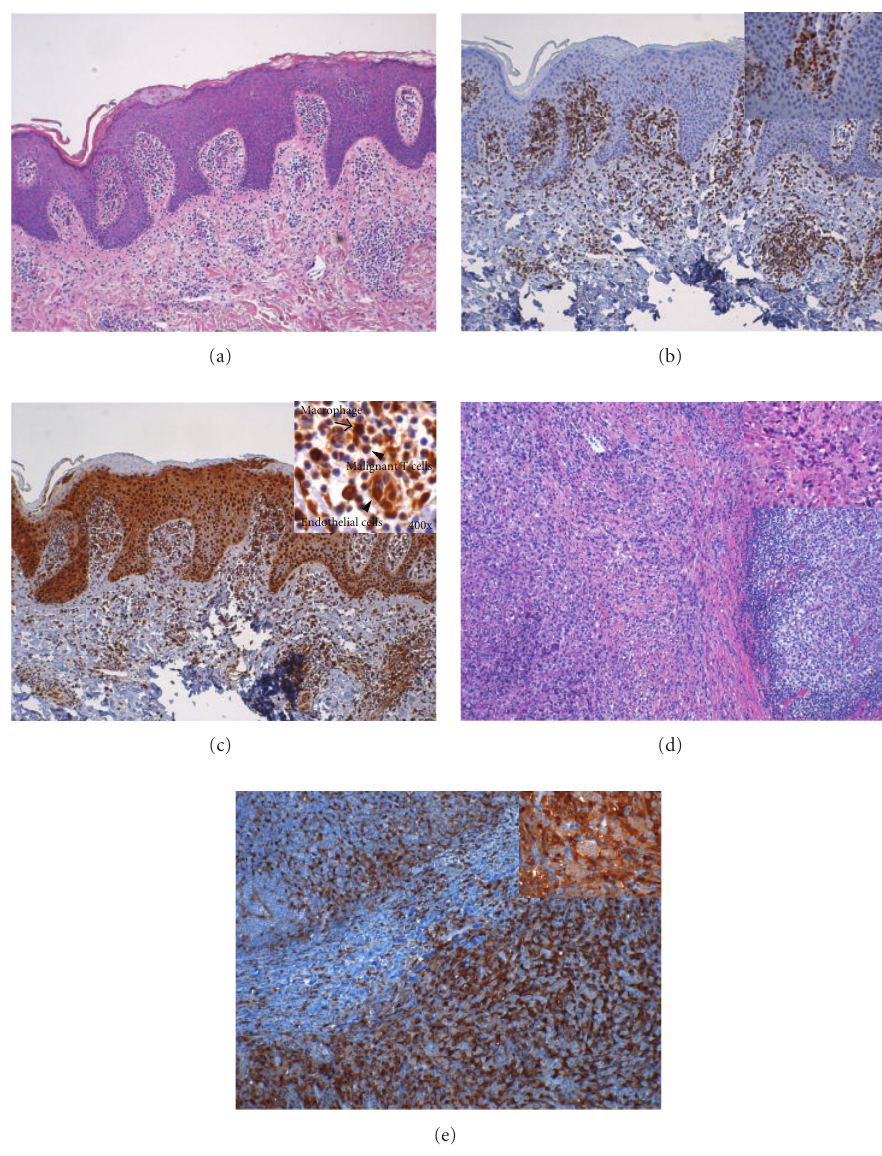
Figure 2: Immunohistochemical stain of thymidine phosphorylase (TP) expression and related markers in skin-involved mycosis fungoides (MF-skin) and in a case of mycosis fungoides/S´ezary syndrome cells with involved lymph nodes (LN-MF) with large cell transformation. (a) MF-skin: hematoxylin and eosin (H&E) stain. (b) MF-skin: CD4 highlights the malignant T cells in the epidermis. (c) MF-skin: TP expression is noted in malignant T cells (arrow in inset; 400x), squamous cells, and endothelial cells (arrowhead in inset; 400x). (d) An MF lymph node with large cell transformation is demonstrated: H&E stain. (e) TP stain shows positive immunoactivity in the transformed large neoplastic T cells (arrow in inset; 400x); macrophages are indicated by arrow in inset (400x). Images are from an Olympus BX41 microscope (Olympus Corp., Tokyo, Japan) processed with Qcapture Pro 5.1 (QImaging, Surrey, BC, Canada).